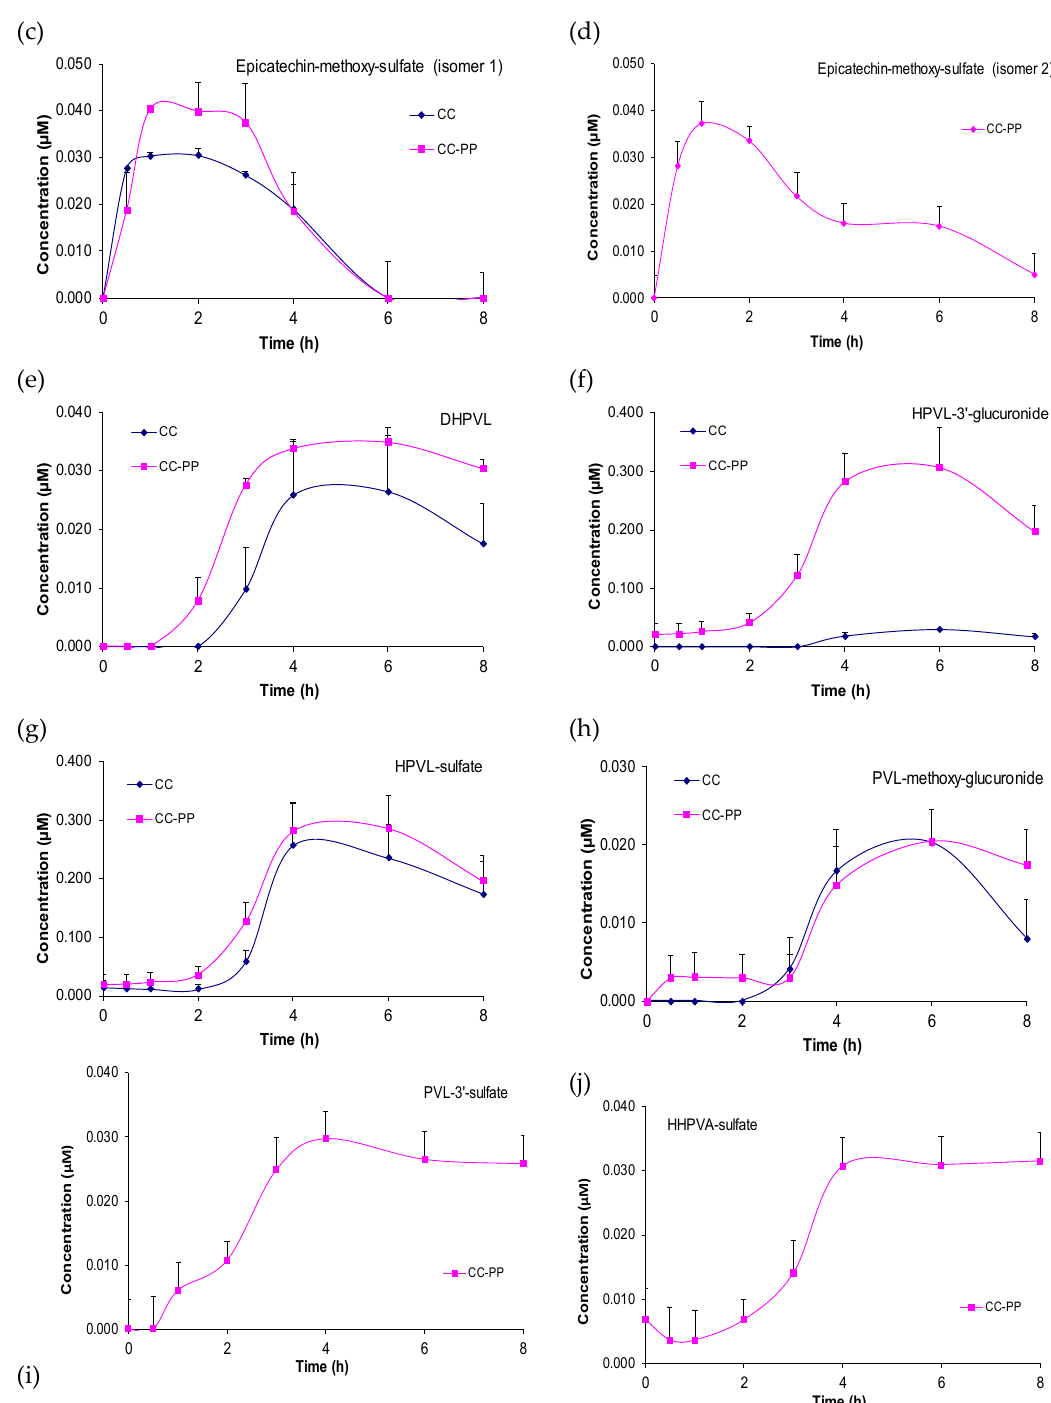
Figure 1. Plasma concentrations of the identified metabolites after consuming a conventional soluble cocoa product (CC) and a flavanol-rich soluble cocoa product (CC-PP) containing 19.80 and 68.25 mg of flavanols, respectively. (a) Epicatechin-3 ′ -glucuronide; (b) epicatechin-3 ′ -sulfate; (c) epicatechin- methoxy-sulfate (isomer 1); (d) epicatechin-methoxy-sulfate (isomer 2); (e) 5-(3 ′ ,4 ′ -dihydroxyphenyl)- γ -valerolactone (DHPVL); (f) 5-(4 ′ -hydroxyphenyl)- γ -valerolactone-3 ′ -glucuronide (HPVL-3 ′ -glucuronide); (g) 5-(hydroxyphenyl)- γ -valerolactone-sulfate (HPVL-sulfate); (h) 5-phenyl- γ -valerolactone-methoxy-glucuronide (PVL-methoxy-glucuronide); (i) 5-phenyl- γ -valerolactone-3 ′ -sulfate (PVL-3 ′ -sulfate) and (j) 4-hydroxy-5-(hydroxyphenyl)valeric acid-sulfate (HHPVA-sulfate). Results represent concentration (µM) as mean ± standard deviation ( n = 13). The lower part of the error bars is not displayed for the sake of clarity.